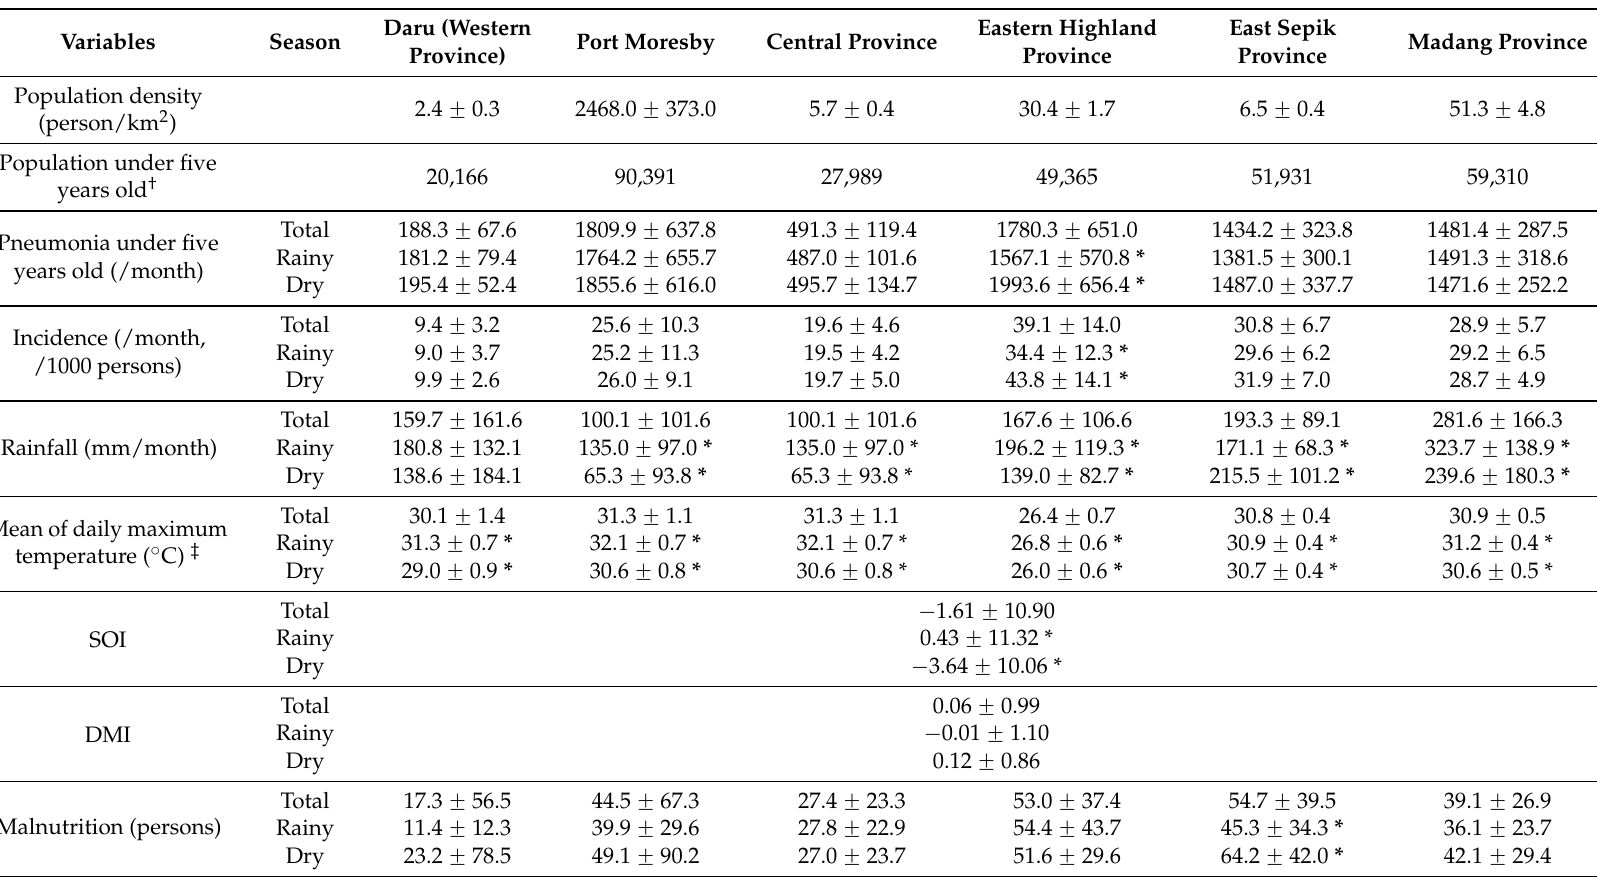
Table 1. Descriptive statistics of the six areas in Papua New Guinea between 1997–2006 (mean ˘